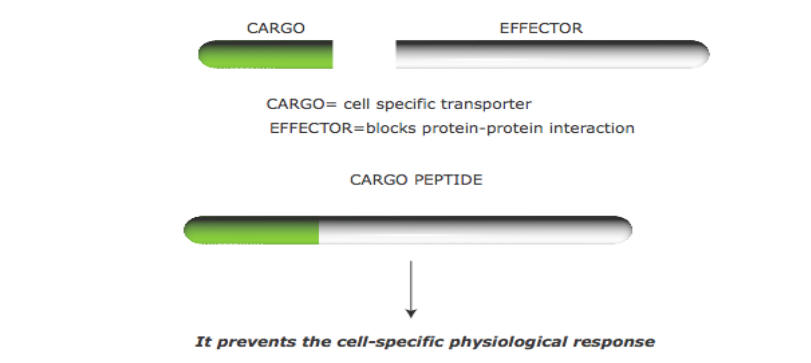
Figure 1. Schematic representation of a typical Cell Permeable Peptide. CPPs are composed of a Cargo molecule (TAT-green) that allows cell penetration and an Effector (white) molecule that interferes with a specific protein interaction. This peptide results in a bioactive cargo that is able to interfere with a cellular physiological response